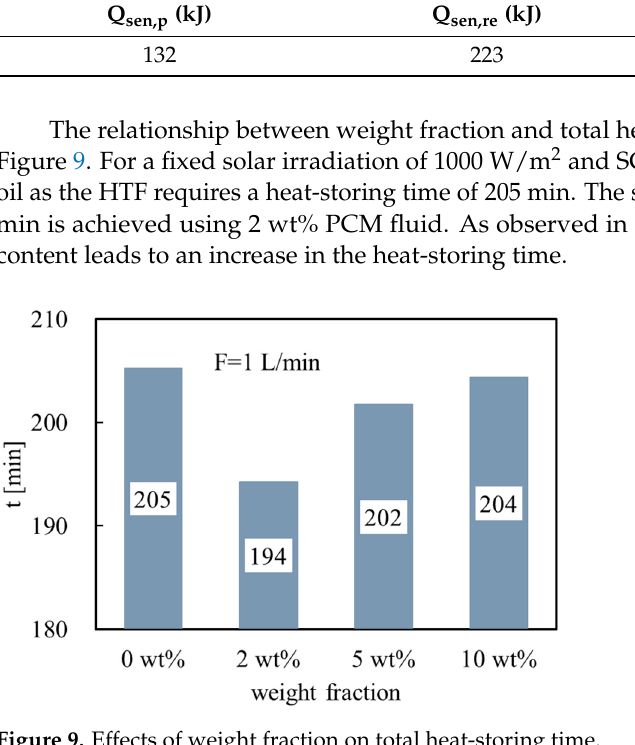
Figure 9. Effects of weight fraction on total heat-storing time.